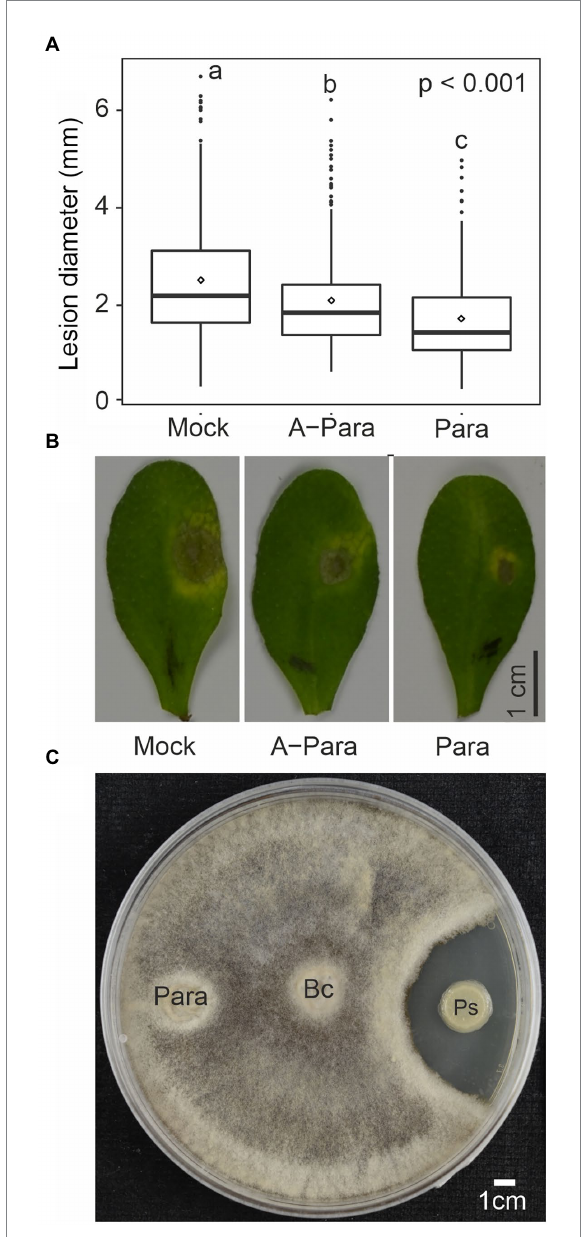
FIGURE 4 Priming effect by P. arabidopsidicola . (A) Lesion diameters from drop infection of Botrytis spores on leaves of Arabidopsis pre-treated with water (mock), autoclave killed Protomyces arabidopsidicola C29 (A-Para), or live Para. The pooled data from six independent biological repeats (total n = 24) is displayed in standard boxplots (central 50% of the data range in the box, with a line showing the median, bars depict the range of remaining data, and dots display outlier data points). Statistics performed with pooled data from by computing a linear mixed model in R (v3.5.1). (B) Photos of Botrytis - induced necrosis on leaves of Arabidopsis that were pre-treated with water (mock), autoclave killed Para (A-Para), or live Para. (C) No direct growth inhibition by P . arabidopsidicola strain C29 (Para) was observed against Botrytis cinerea (Bc) in co-cultivation assays. As a control, a Paenibacillus sp. (Ps) known to have antifungal activity against Botrytis was used. Yeast extract-peptone-dextrose agar plates were used for cultivation. Photos were taken 7 days post inoculation. Experiment was repeated three time with similar results and one representative result is